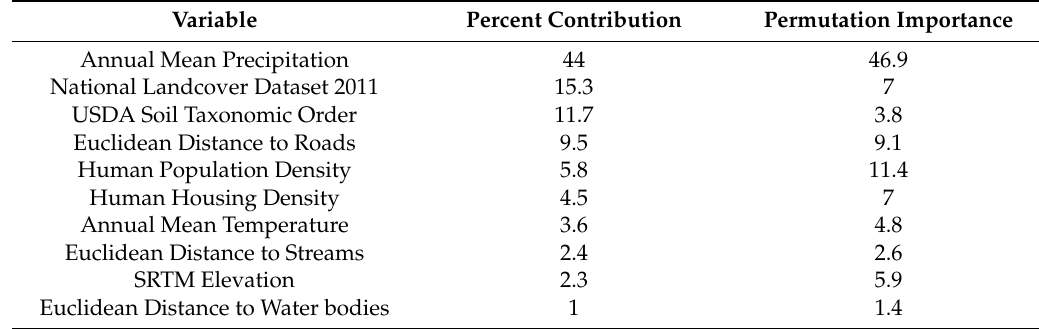
Table 4. Raccoon ( n = 171) risk modeling sample data for pine-dominated landscapes of Massachusetts during 5 January 2012–26 June 2014. All values are